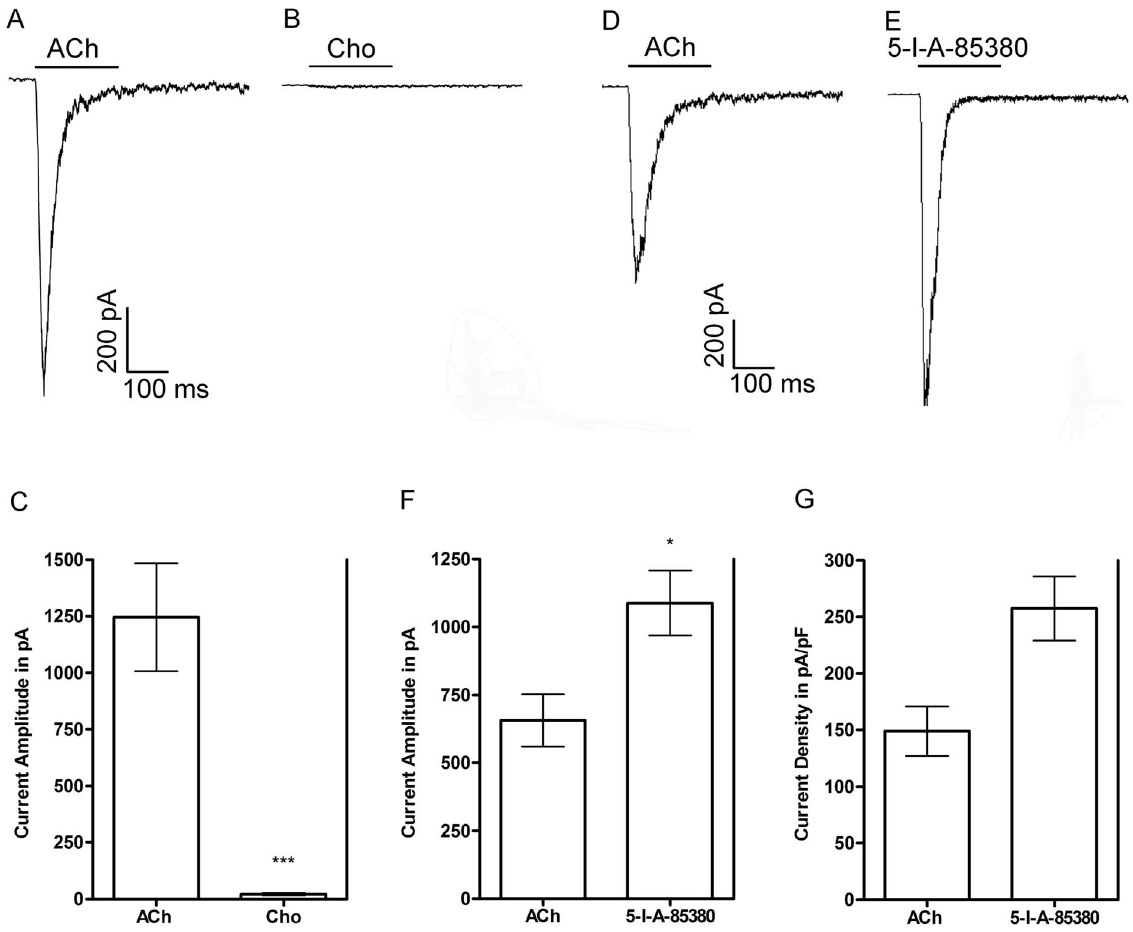
Figure 2. Representative trace recordings of agonist-evoked currents from monkey adrenal chromaffin cells. A and B, Current traces of ACh- and choline-evoked currents from a single cell. C, Quantitative comparison of the current amplitudes evoked by each respective agonist. Responses to 10 mM choline were compared to the average responses evoked by 300 m M ACh in the same cells; the error bars denote the S.E.M. (n=4) and the asterisks denote statistical significance (*** p , 0.0001) as determined by a one sample t-test. D and E, Current traces of ACh- and 5-I-A- 85380-evoked currents from a single cell. F, Quantitative comparison of the current amplitudes evoked by each respective agonist. Responses to 100 m M 5-I-A-85380 were compared to the average responses evoked by 300 m M ACh in the same cells; the error bars denote the S.E.M. (n=4) and asterisk denote statistical significance (* p , 0.05) as determined by a one sample t-test. G, The current amplitudes shown in F were normalized to membrane capacitance and shown as an expression of current density in pA/pF. The differences between the current densities produced by the two agonists were not statistically significant as determined by a Wilcoxon signed rank test ( p =0.0625).